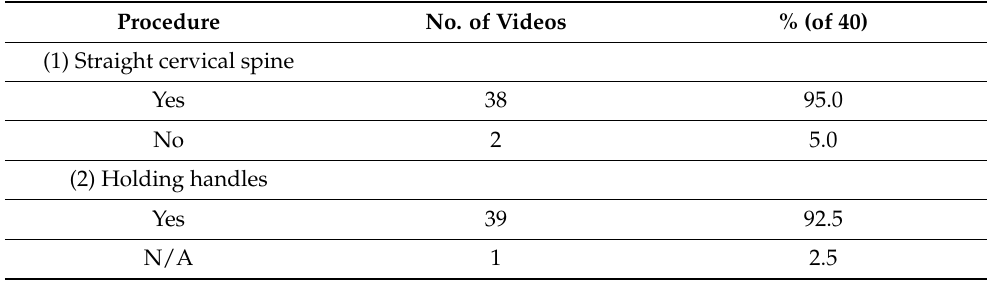
Table 2. Frequency counts of patient positioning